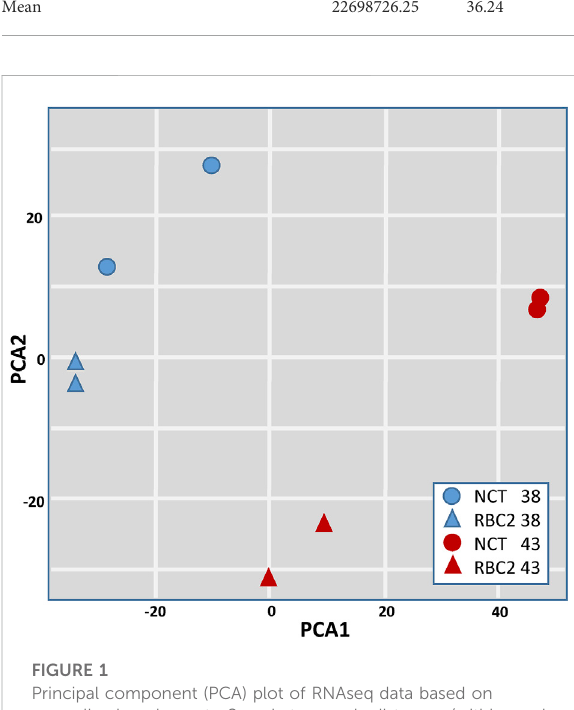
FIGURE 1 Principal component (PCA) plot of RNAseq data based on normalized read counts. Sample to sample distances (within- and between-treatments) are illustrated on the fi rst two principal components. Samples are plotted according to